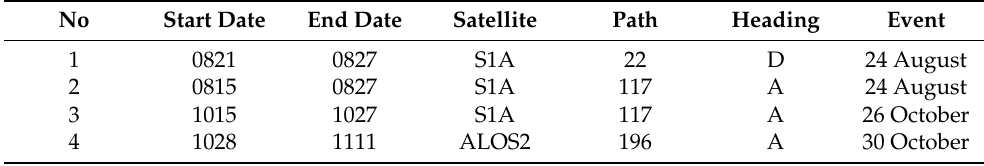
Figure A10. Distribution of seismic activity along the VBFS/GFS systems from the INGV, USGS and DBMI-USGS catalogs. The dashed black rectangles represent the surface projection of the fault planes adopted in this study. The bold red lines are the two seismogenic normal fault systems, namely, the Mt. Vet-tore – Mt. Bove Fault (VBFS) system and the Mt. Gorzano Fault (GFS) system. Table A1. SAR scenes used for generating the coseismic